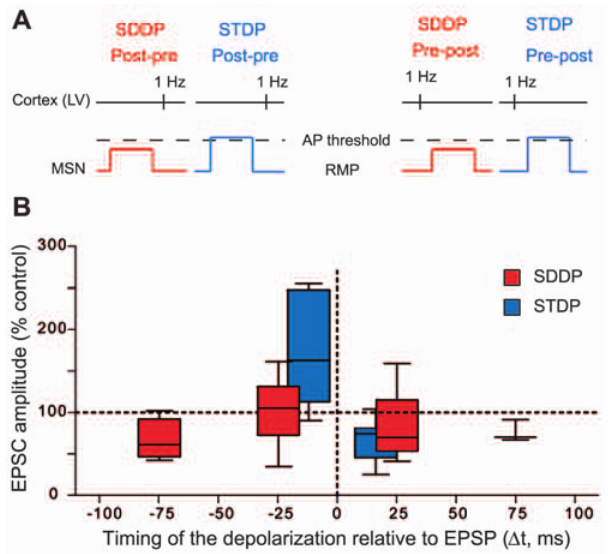
Figure 6. Comparison of the occurrence, orientation, magni- tude and temporal extent of SDDP and STDP. ( A ) Schematic representations of post-pre and pre-post SDDP and STDP protocols (the two protocols differ by the presence or not of a postsynaptic action potential). ( B ) Long-term synaptic efficacy changes evoked by SDDP and STDP protocols illustrated with Box and Whiskers plots. When compared to SDDP, STDP changes were strictly orientated. SDDP changes were inducible in wider time windows than STDP ( + / 2 110 vs. + / 2 30 ms). sdLTP were induced in a time window 1.7 fold wider than those of STDP LTP while the time window for sdLTD induction was 3.3 fold wider when compared to STDP LTD. Data concerning STDP experiments are taken partly from a previous study (Fino et al., 2005), with the addition of new experiments performed in perforated patch- clamp